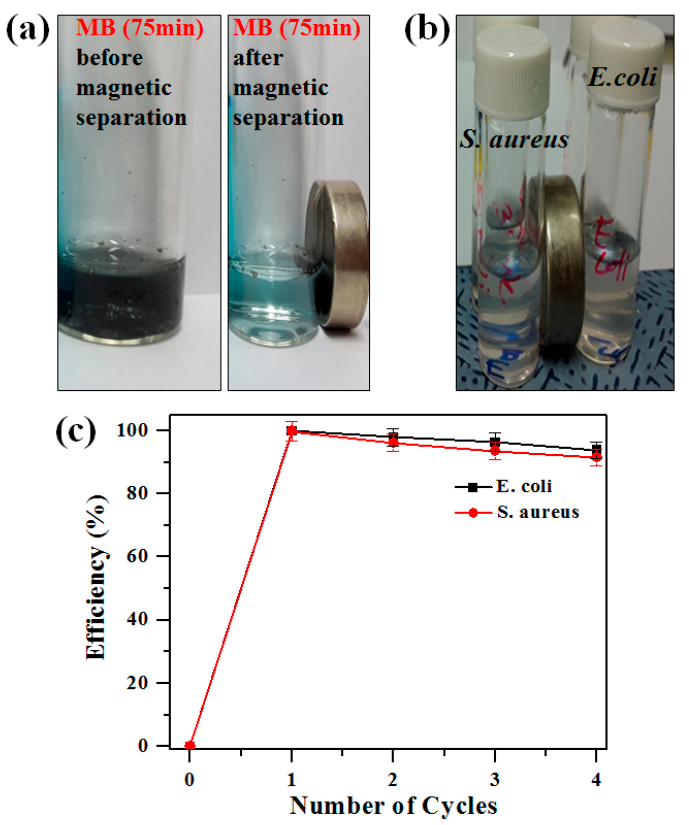
Figure 7. ( a ) Comparison of methylene blue solutions before and after magnetic separation of the nanocomposites after 75 min of light exposure. ( b ) Photo images of bacterial cells ( E. coli and S. aureus ) after 10-min-long magnetic separation of the nanocomposites. ( c ) Degradation efficiency of bacterial cells ( E. coli and S. aureus ) in the presence of Fe 3 O 4 /Pd/mpg-C 3 N 4 nanocomposites (100 μ g/mL) under solar light irradiation over four cycles of tests. (b) Recovery mechanism of nanocomposite from bacterial cells with magnetic separation for 10 min.